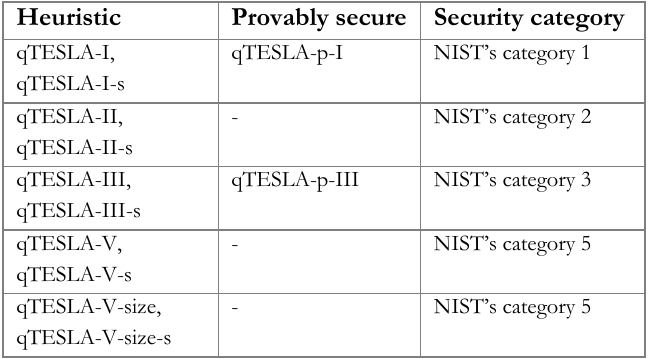
Table 3. Parameter sets and their targeted security [14]